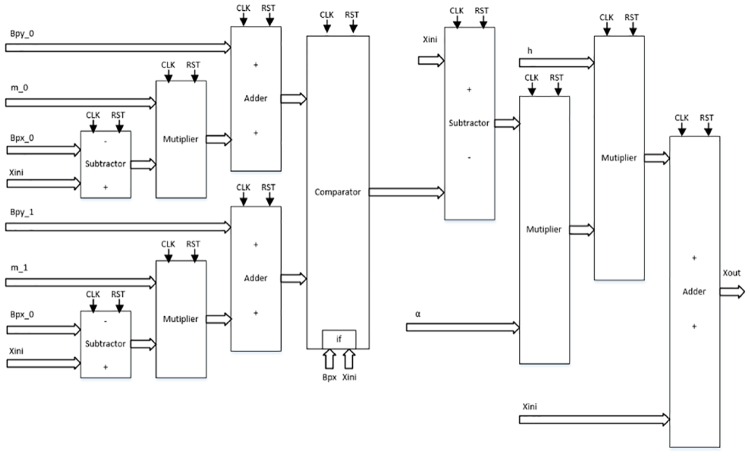
Hardware connection for implementing x[k + 1] from Eq (12).